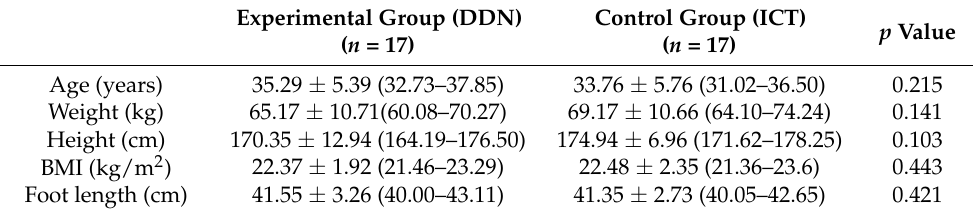
Table 1. Sociodemographic characteristics according to the division by treatment